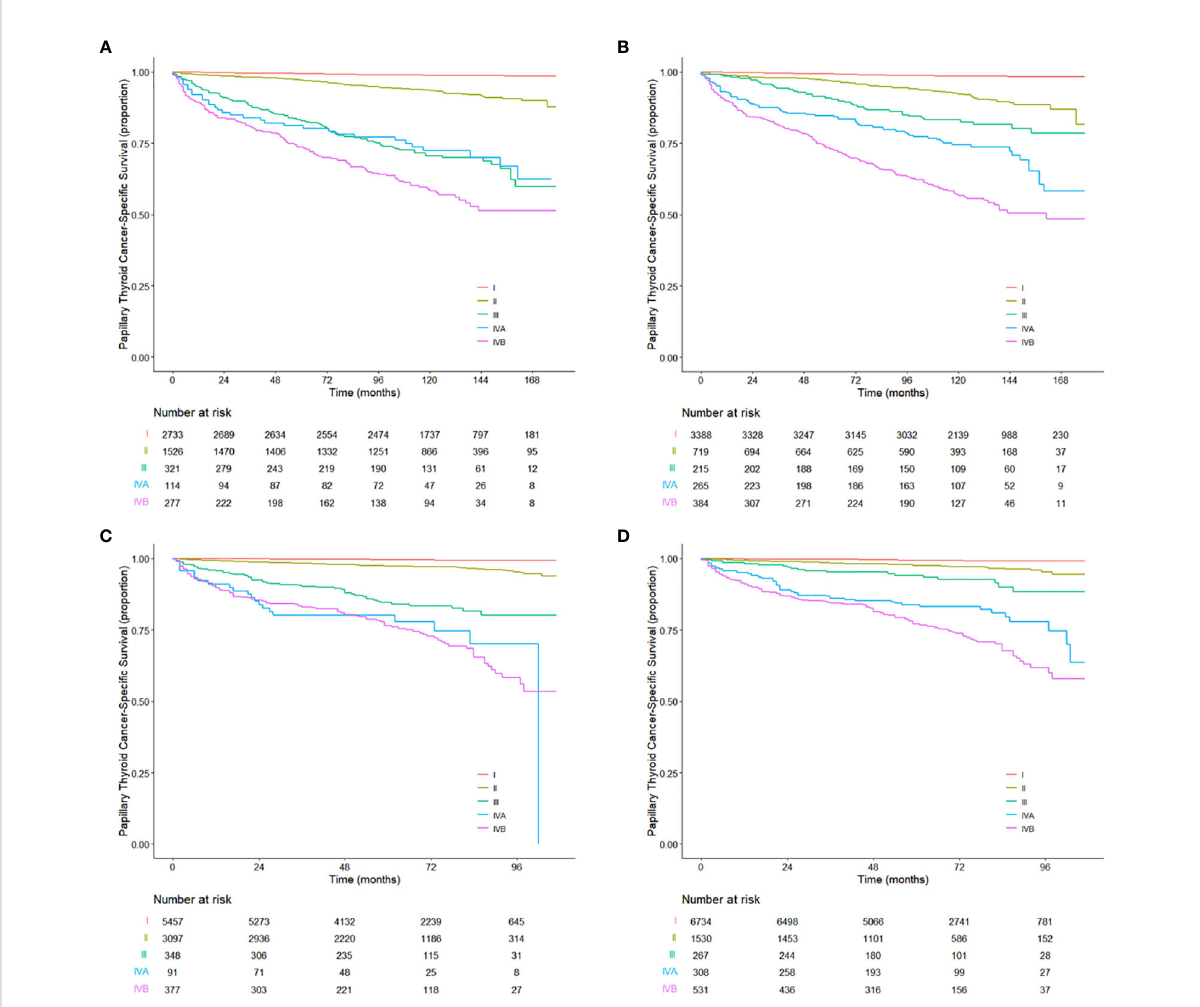
FIGURE 3 Kaplan-Meier estimates for the patients aged 55 years or older from (A) the training cohort and (C) the validation cohort using the current TNM staging system. Kaplan-Meier estimates for the patients aged 55 years or older from (B) the training cohort and (D) the validation cohort using the revised TNnM staging